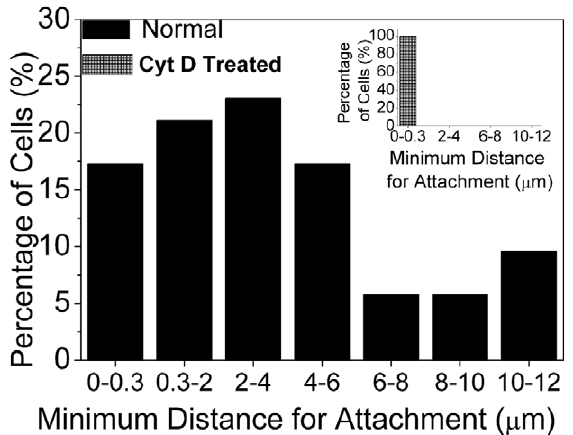
Figure 14. Histogram depicting the minimum distance of approach before two cells adhere to each other through filopodial interactions. Inset shows the corresponding histo- gram when the cells have been treated with 0.1 m M Cytocha- lasin-D.